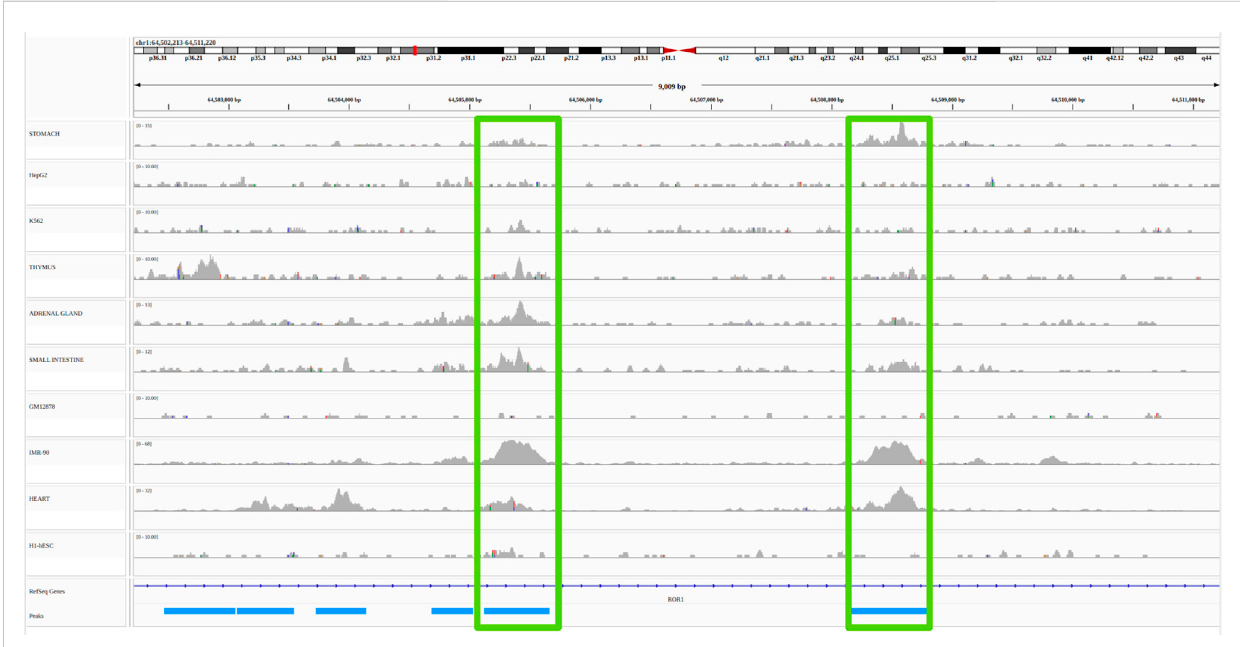
FIGURE 2 Example of a non-supervised/heuristic method for the identi fi cation of E/G in a cell type: the open chromatin correlation method. A common approach to identify candidate E/G is to investigate the correlation between chromatin accessibility signal at two regions across several cell types. The plot represents a portion of the human genome (from position 64,502,213 to position 64,511,220 of chromosome 1 on the hg19 human genome assembly) in IGV (Integrative Genomics Viewer). The horizontal tracks represent ENCODE DNAse-seq signal in 10 different cell types, followed by gene annotation (Refseq) in dark blue and by DNAse-seq consensus peaks from the 10 cell types in light blue. The vertical green rectangles highlight two consensus peaks (and their signal) that have a high (more than 0.7) Pearson correlation between the log 10 of their normalized accessibilty across the 10 cell types (see Material and methods ). If one of the consensus peaks was at the transcription start site (TSS) of a gene, then it would typically be interpreted as an